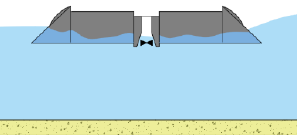
Figure 3. Schematic diagram of overtopping WEC.